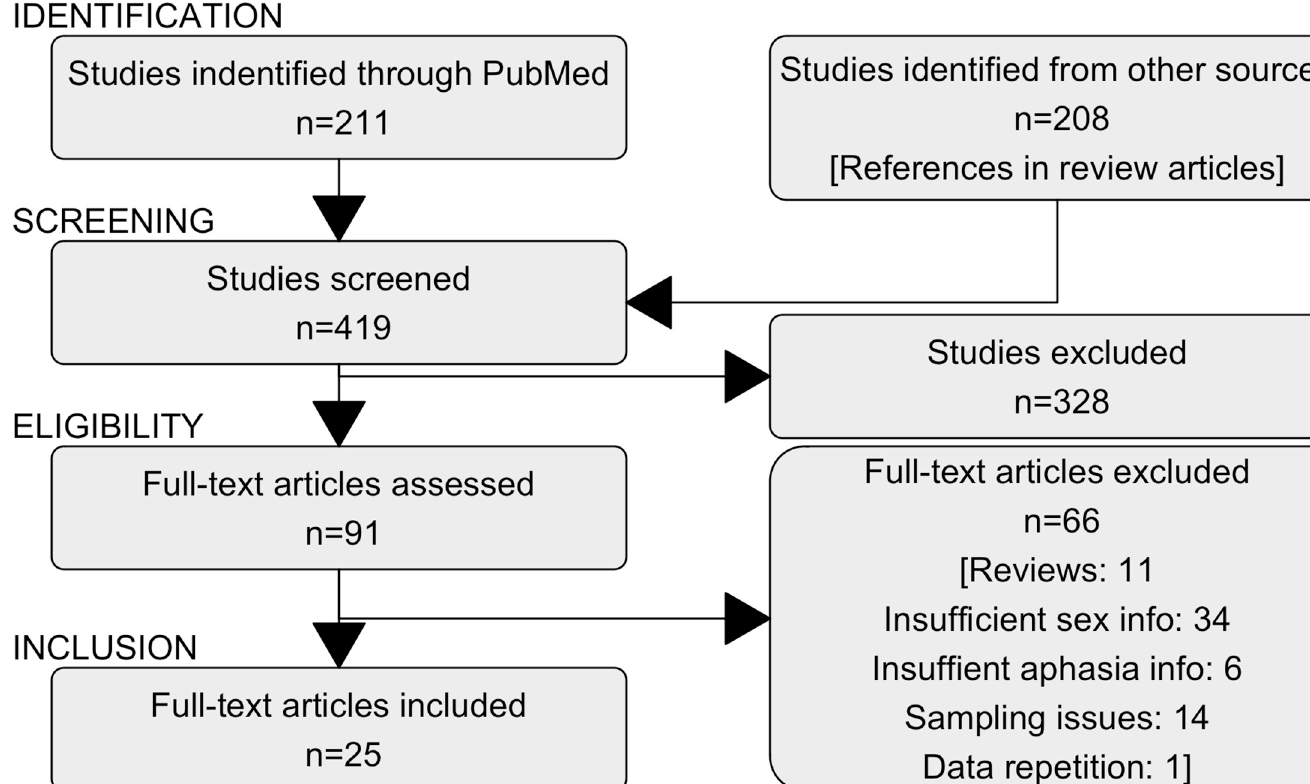
Fig 1. Data gathering flow-chart. Flow chart depicting the different phases of data gathering.